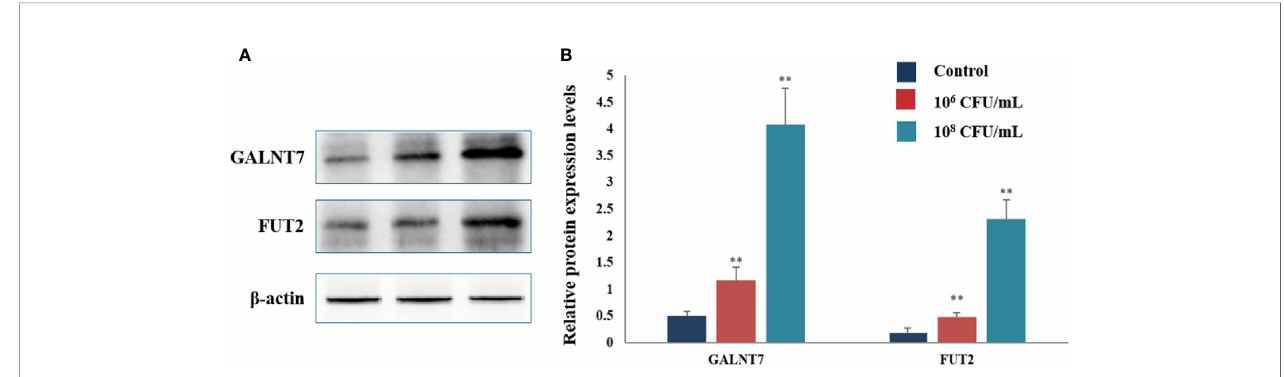
FIGURE 6 | C. butyricum promoted the expression of GALNT7 and FUT2 of HT-29 cells. n=3. (A) Western blot analysis for GALNT7 and FUT2, normalized by b - actin. (B) Quantitative analysis for the densitometry of the proteins performed using ImageJ software. Results are expressed as means and standard deviation of three independent experiments with ** P <